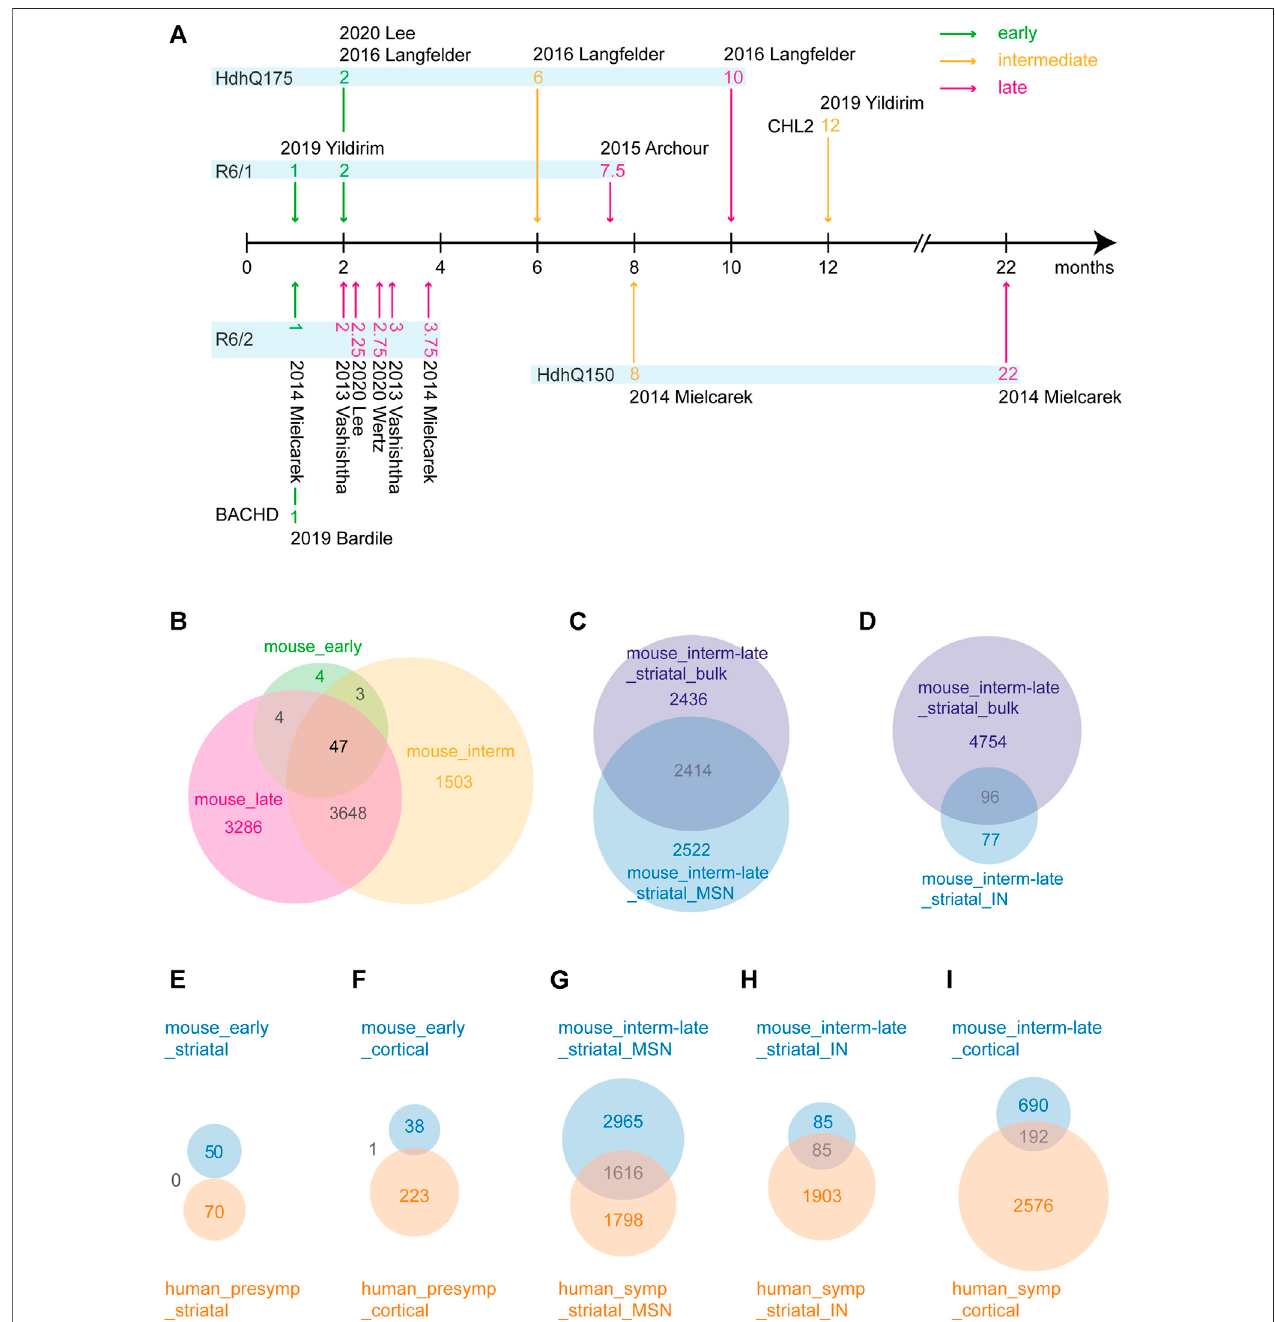
FIGURE 7 | Differentially expressed gene (DEG) analysis and overlap between mouse and human datasets. (A) HD mouse model disease progression timeline. Basedonexistingliterature,timepointsfromHDmodelsarecategorizedasearly,intermediate andlatediseasestage. (B) VenndiagramofDEGoverlap betweenmouse early, intermediate and late categories. (C) Venn diagram of DEG overlap between mouse intermediate/late bulk striata and mouse intermediate/late striatal medium spiny neurons. (D) Venn diagram of DEG overlap between mouse intermediate/late bulk striata and mouse intermediate/late striatal interneurons. (E – I) Corresponding cell types and disease stages between human and mouse categories were compared. Blue denotes mouse categories; orange denotes human categories.